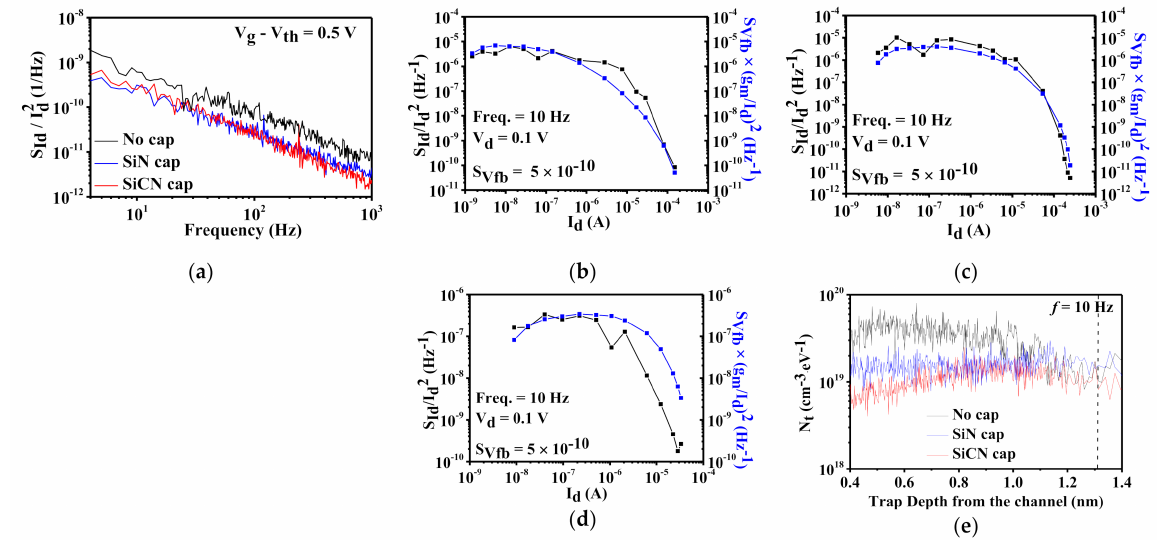
Figure 5. ( a ) Normalized noise spectral density (S Id /I d2 ) according to the f at V g – V th = 0.5 V and V d = 0.1 V. S Id /I d2 (red circle) and (g m /I d ) 2 (blue line) versus I d at V d = 0.1 V and f = 10 Hz for AlGaN/GaN HEMTs with ( b ) in situ SiCN, ( c ) SiN, and ( d ) no cap layer. ( e ) Trap density (N t ) versus trap depth (Z), taken from the noise spectrum at V g ~V th for three